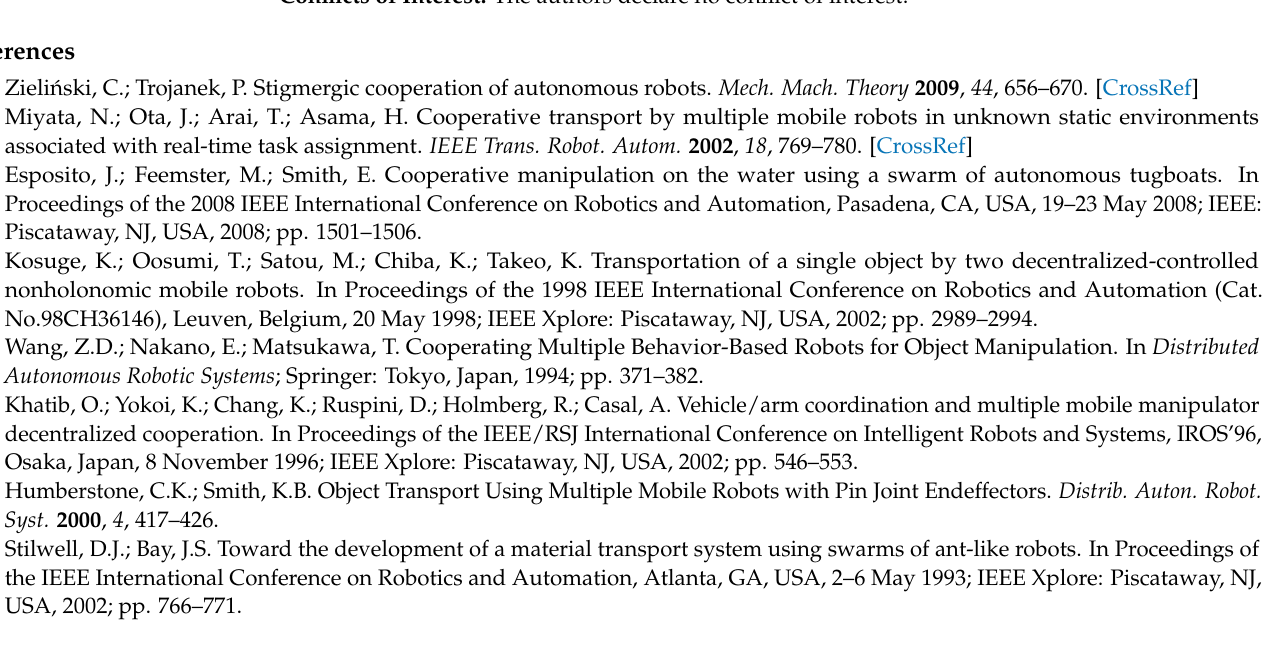
Figure 6. ( a ) The course of the implementation of the transport task, and ( b ) solving the inverse dynamics problem.